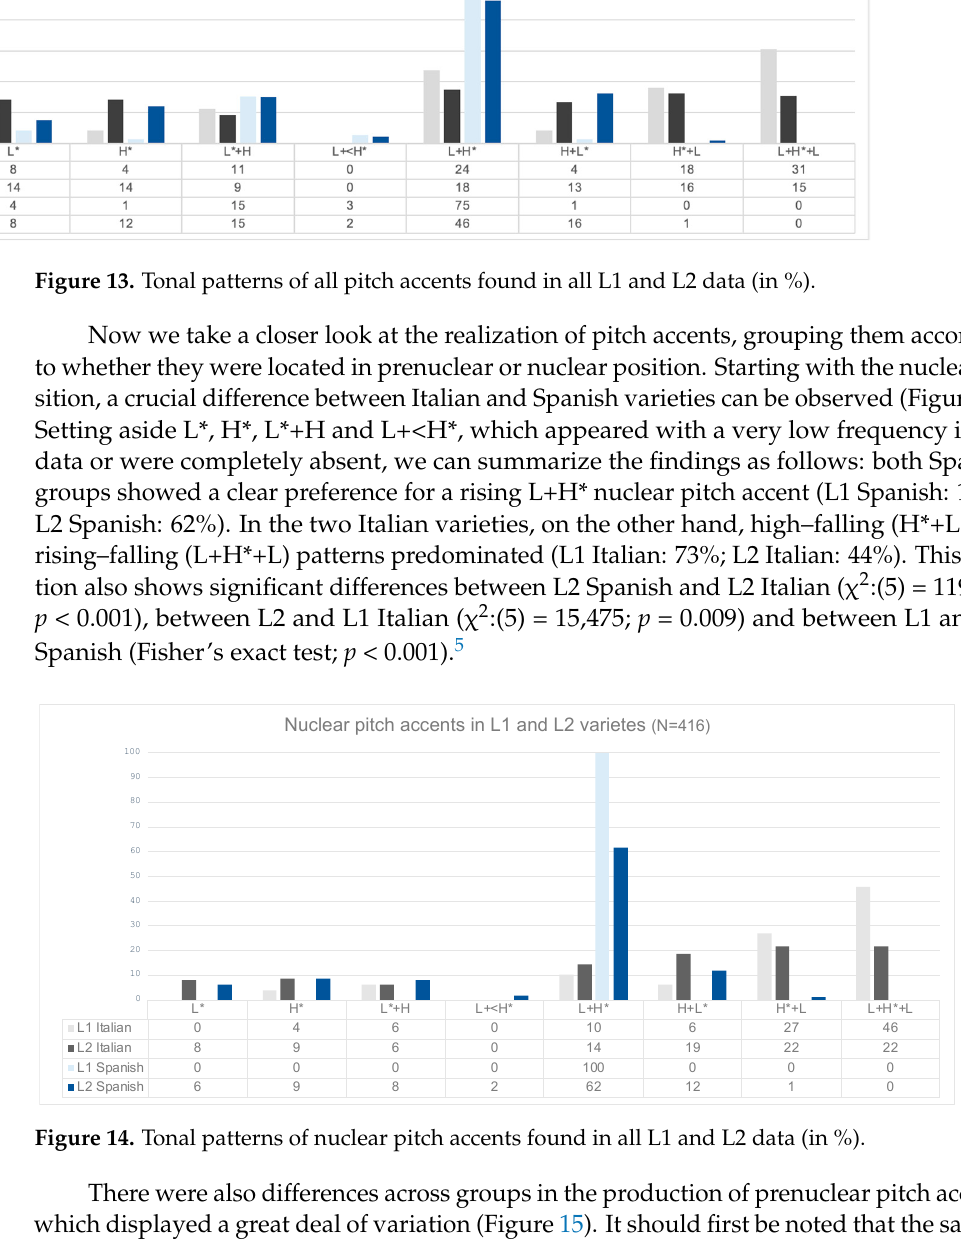
14 of 27 Figure 12. Schematic representation of boundary tones found in the data (the dotted line indicates alternative pitch tracks) (Pešková 2020). The corpus for the present analysis consisted of 260 target non-neutral statements and 1040 tonal events, comprising prenuclear and nuclear pitch accents and boundary tones at the intonational phrase (IP) or intermediate phrase (ip) within the Prosodic Hier- archy (see, e.g., Selkirk 1984). The number also included the greeting (S18; ‘ Hi, Roberto! ’) and the negative particle no (S04; ‘ No, oranges ’), since they revealed some interesting tendencies in the two L2 varieties. 5. Results 5.1. Intonational Patterns In the dataset, several substantial differences between the two L2 varieties were found. Given that we are interested in frequency distributions across groups and we are